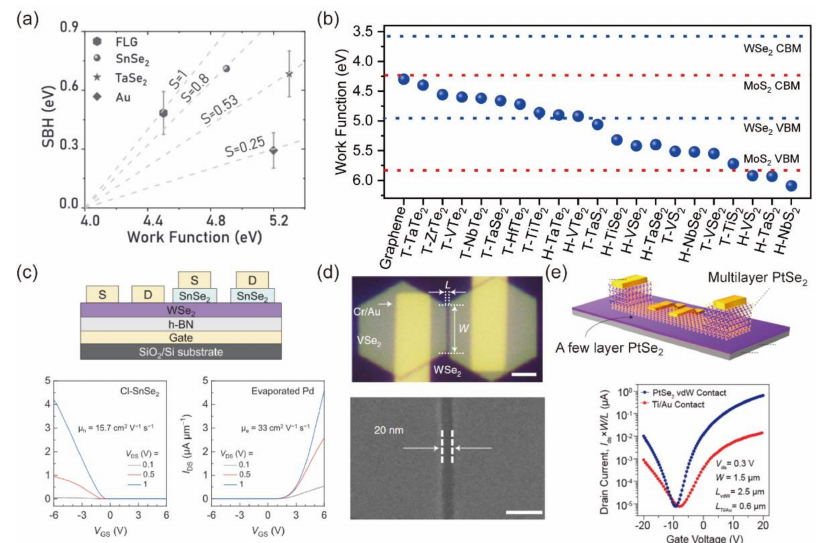
Figure 4. ( a ) Fermi-level de-pinning with vdW contacts. Reprinted/adapted with permission from Ref. [41]. Copyright 2021, John Wiley and Sons. ( b ) Band alignment of MoS 2 and WSe 2 with 2D metals and semimetals [42]. ( c ) Schematic and transfer curves of WSe 2 devices contacted with both evaporated Pd and Cl–SnSe 2 electrodes. Reprinted/adapted with permission from Ref. [45]. Copyright 2022, John Wiley and Sons. ( d ) Optical microscopy and SEM images of the bi-layer WSe 2 transistor. Reprinted/adapted with permission from Ref. [9]. Copyright 2022, Springer Nature. ( e ) Schematic illustration of few-layer PtSe 2 FETs with metallic PtSe 2 vdW contact and a conventional Ti/Au contact. Reprinted/adapted with permission from Ref. [50]. Copyright 2021, American Chemical